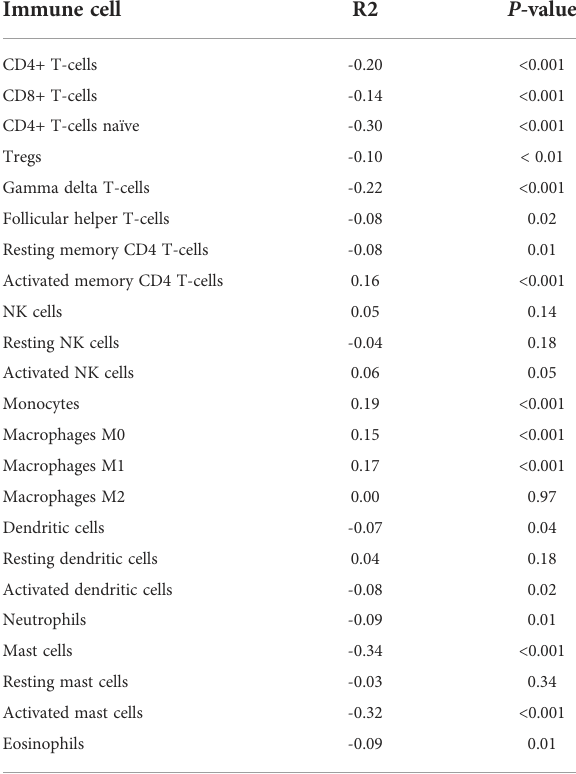
TABLE 4 Correlations between degree of stemness with immune cell types. Immune